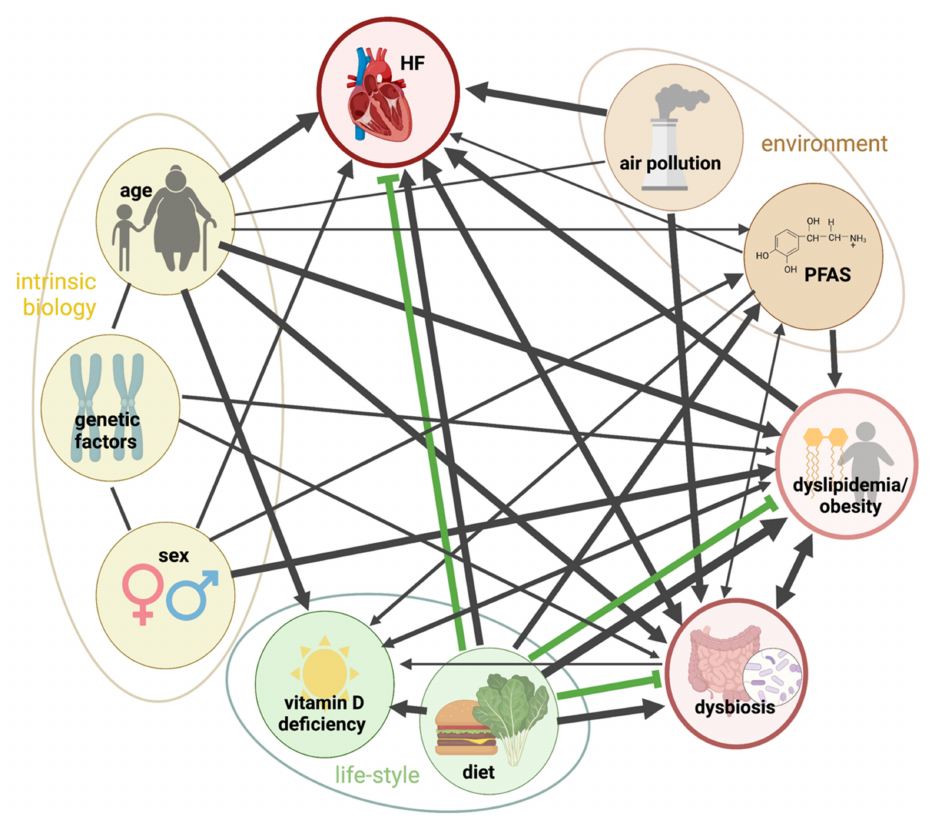
Figure 5. Interplay between the MFs investigated in this study. Black arrows: negative effect (arrow width indicating approximative magnitude). Green inhibitor arrows: potential positive effect. Arrows in both directions: mutual effect. Created with Biorender.com